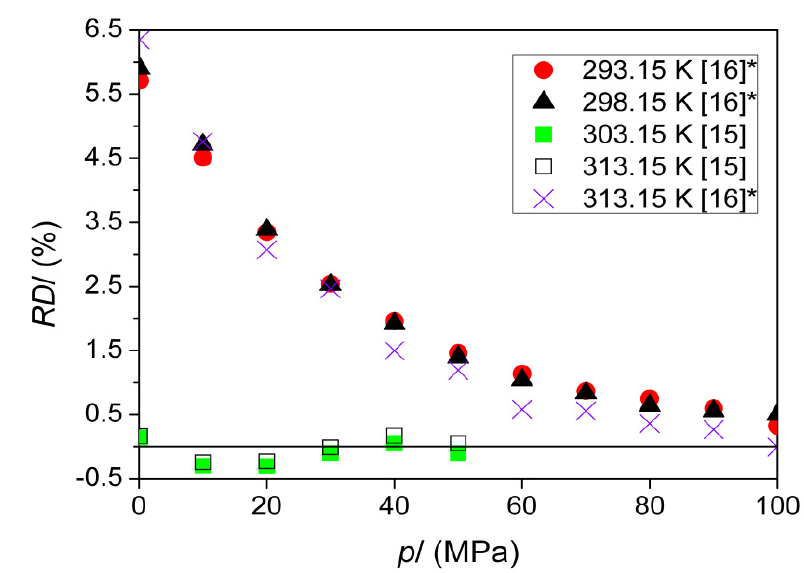
Figure 6. Comparison of the isentropic compressibility of 1-butanol as a function of pressure obtained in this work ( κ S , this work ) with the literature values ( κ S , lit ) [15,16] presented as relative deviations RD s ( RD / % = 100 · ( κ S , this work − κ S , lit ) / κ S , this work ); * calculated from the p ρ T data [16]. Based on the temperature dependence of density, the isobaric thermal expansion was calculated using a definition (Equation (4)). The obtained results are collected in Table 8. The overall expanded − 2 α − 1 uncertainty of α p is U ( α p ) = 1 · 10 . The agreement with literature data is very good, the RDs are p K in the range from − 1.9 to 0.17% [16] and from − 2.2 to 0.19% [17] (see Figure 7). The AARD is 0.83% [16] and 1.0% [17]. Table 8. The isobaric thermal expansion, α p , of 1-butanol at pressures up to 100 MPa and within the temperature range from (293 to 318) K. p